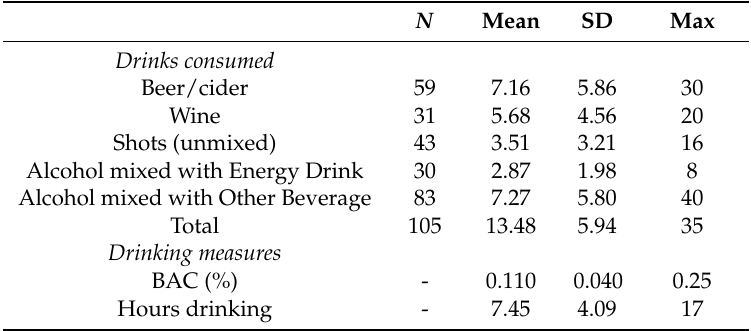
Table 2. Reported drinking characteristics, including types of drinks consumed on the night of data collection, Breath Alcohol Concentration (BAC), and hours drinking.